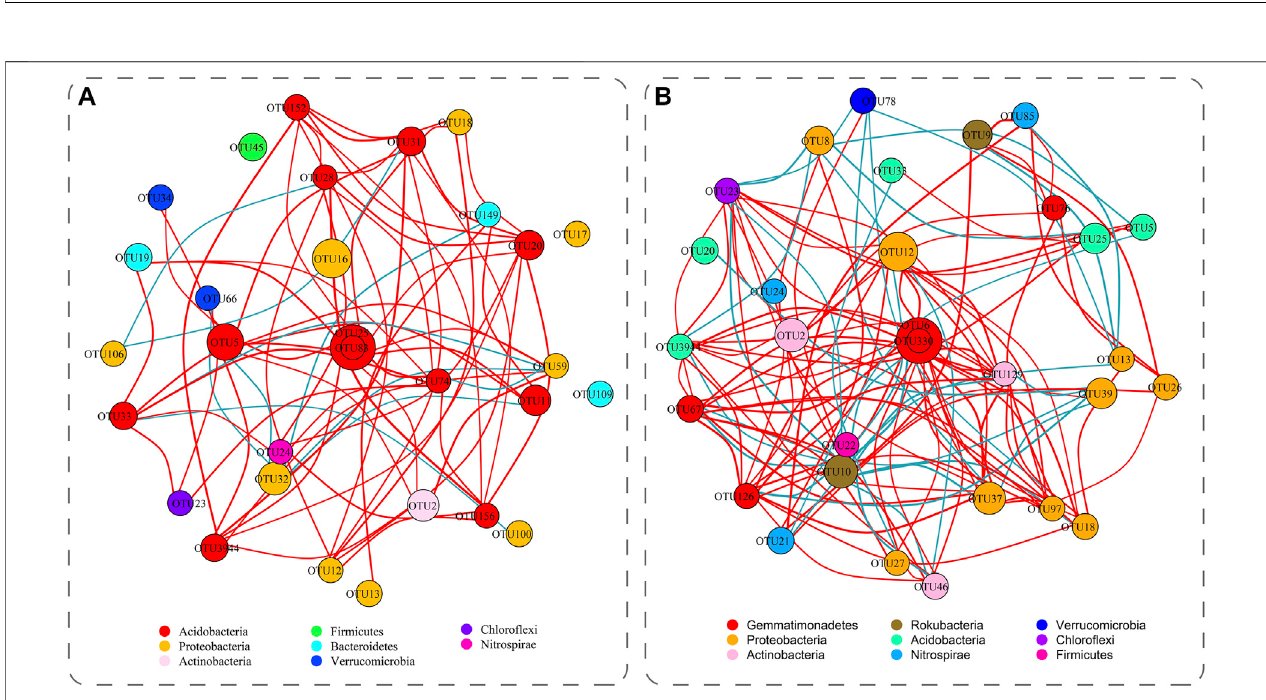
FIGURE3| ThenetworkofdominantbacterialOTUsoftopsoil (A) andsubsoil (B) inallsites.Thenodesinthenetworkrepresentthetop30OTUs.Thesizeofeach node is proportional to the relative abundance. The red edge represents the positive correlation between OTUs, the blue edge represents the negative correlation. The colors of the nodes represent different soil bacteria phyla. Note: Site abbreviations are de fi ned in Figure 1 .